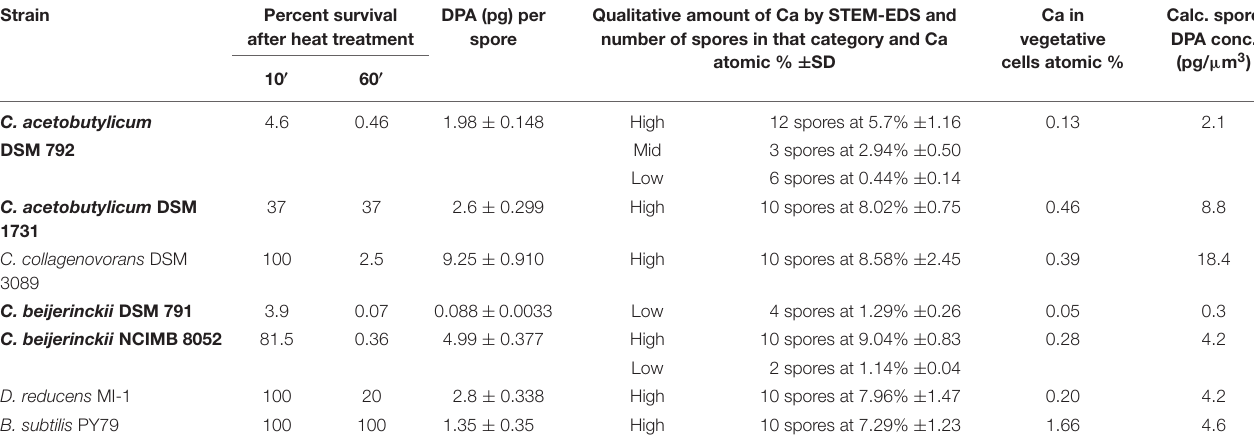
TABLE 2 | Table of spore survival after 10 and 60 min of wet heat treatment (80 ◦ C) expressed as the percentage of spore survival (determined by the MPN method) as compared to an untreated sample. Strain Percent survival DPA (pg) per Qualitative amount of Ca by STEM-EDS and after heat treatment spore number of spores in that category and Ca atomic % ± SD